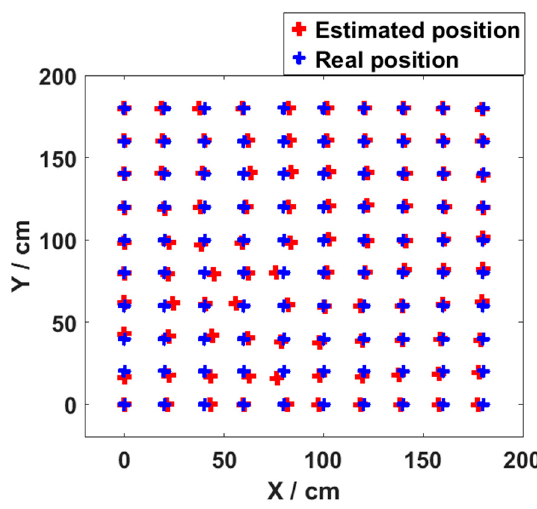
Figure 13. Final 2D positioning results with arbitrary training data set.